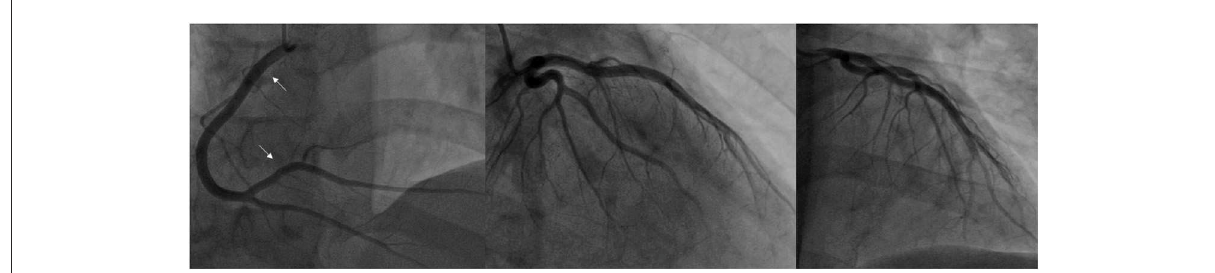
FIGURE2 Coronary angiogram when recurrent chest pain episodes occurred after PCI. Both left and right coronary arteries are patent, their filling is unimpaired. No narrowings in the mid RCA, LAD and LCx, which were observed during the initial coronary angiogram, are present. White arrows indicate stents implanted in the RCA (LAD, left anterior descending artery; LCx, left circumflex artery; RCA, right coronary artery).